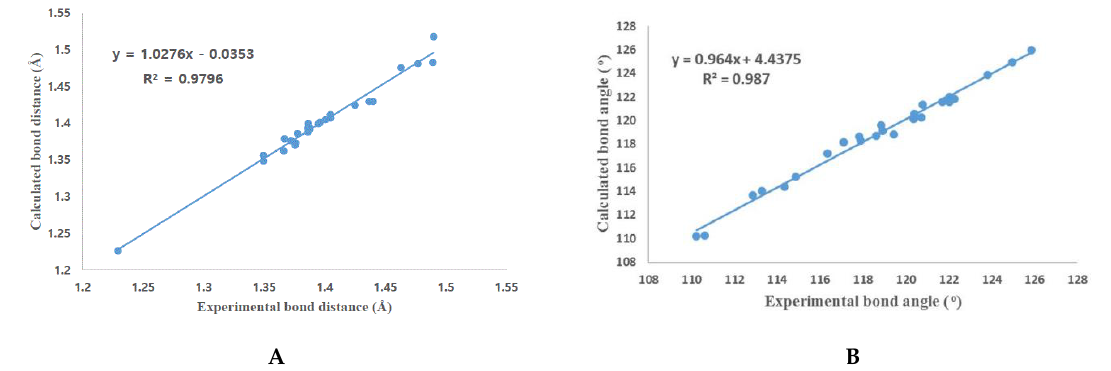
Figure 7. Correlation between the experimental and calculated bond lengths ( A ) and bond angles ( B ) of compound 6 .